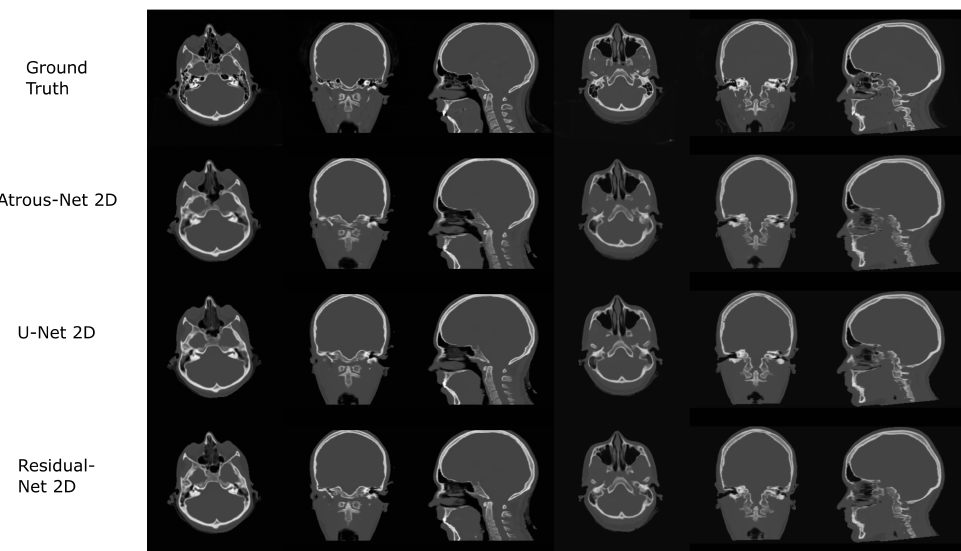
Figure 6. Head results using 2D